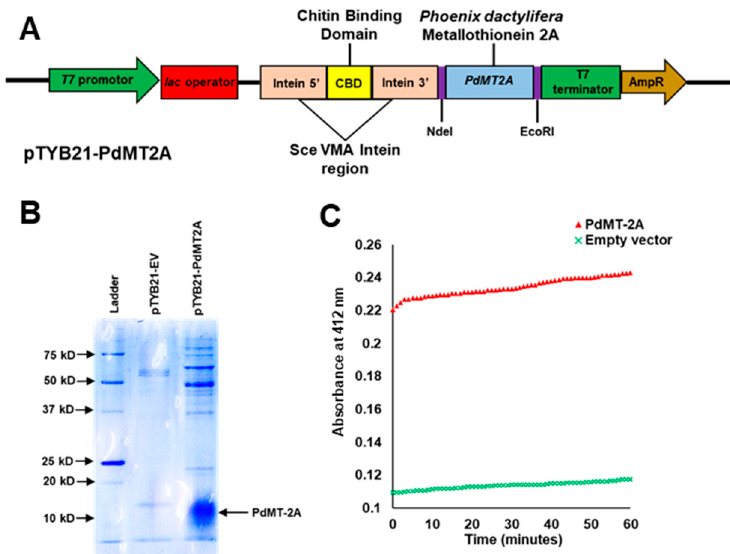
Figure 2. Production of recombinant PdMT2A protein in E. coli. Schematic representation of the expression vector ( A ). The polyacrylamide gel image of the partially purified recombinant PdMT2A protein and the protein produced by the pTYB21 empty vector in E. coli . ( B ). The reactivity of the recombinant PdMT2A protein and the empty vector against the 5,5’-dithiobis-2-nitrobenzoic acid (DTNB) substrate shows the initial speed of the reaction from the plot of absorbance versus time ( C ).